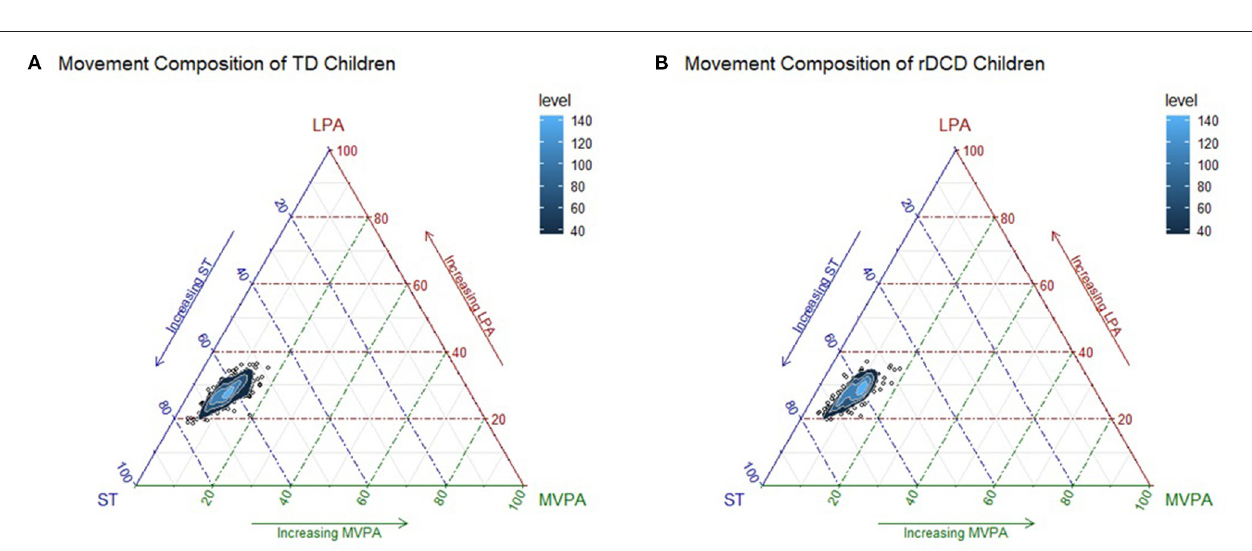
FIGURE 2 | Ternary plots of the sample compositions of time spent in sedentary time (ST), light physical activity (LPA) and moderate-to-vigorous physical activity (MVPA), for TD (A) and rDCD children (B) with 2D kernel density